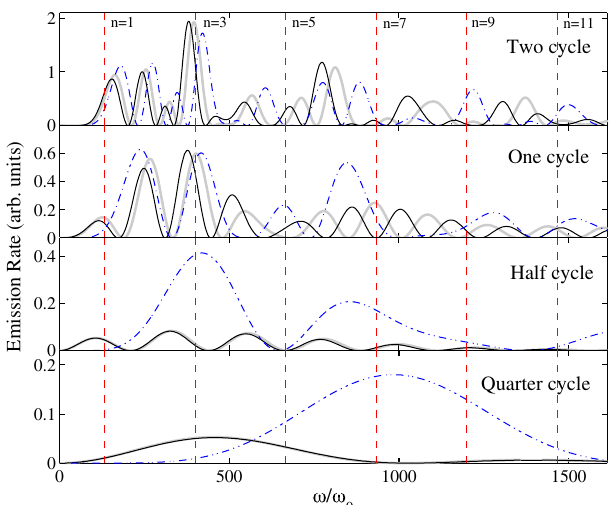
FIG. 9. Emission spectra for laser pulses of decreasing duration (FWHM). The laser is of peak intensity a 0 ¼ 2 and wavelength λ ¼ 0 . 8 μ m. The electron has an initial γ 10 . Gray (thick) 0 ¼ lines: spectra calculated for a plane wave. Black (solid) lines: spectra calculated using a 5th order paraxial beam focussed to a spot size of w 0 ¼ 0 . 8 μ m ( θ 0 ¼ 1 = π ). Blue (dash-dot) lines: the same but modeled using the vector beam model. Red (dashed) lines: the locations of the harmonic peaks for the case of an infinite plane wave (see Sec. III